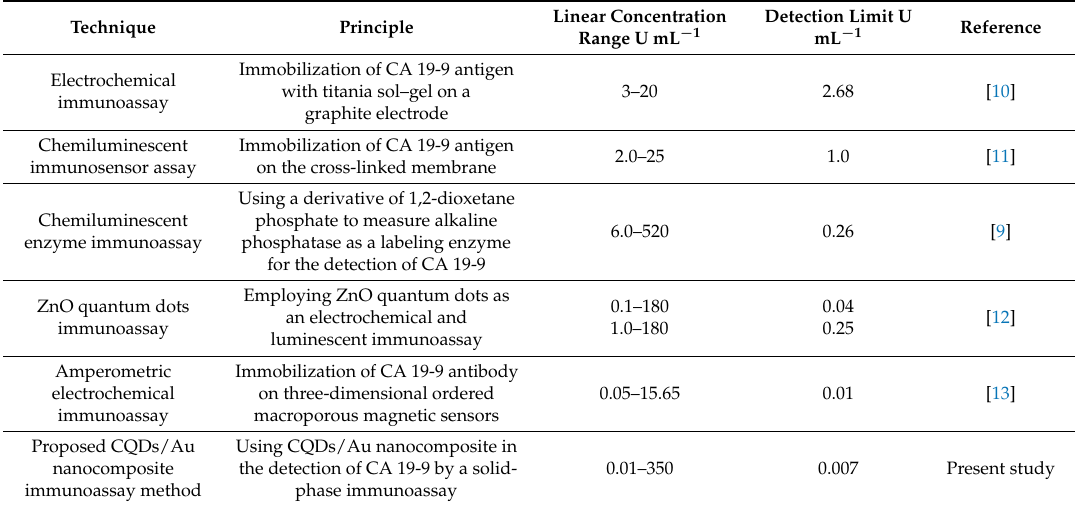
Table 1. A comparative study between the proposed carbon quantum dots/gold (CQDs/Au) nanocomposite immunoassay technique and the other previously published approaches.